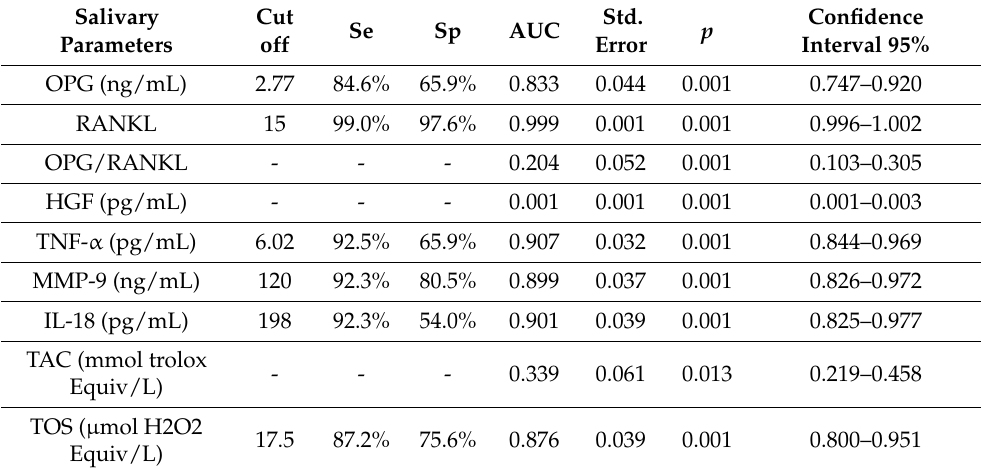
Table 3. ROC curve. Prediction of salivary markers in the determinism of HbA1c > 6.5%.